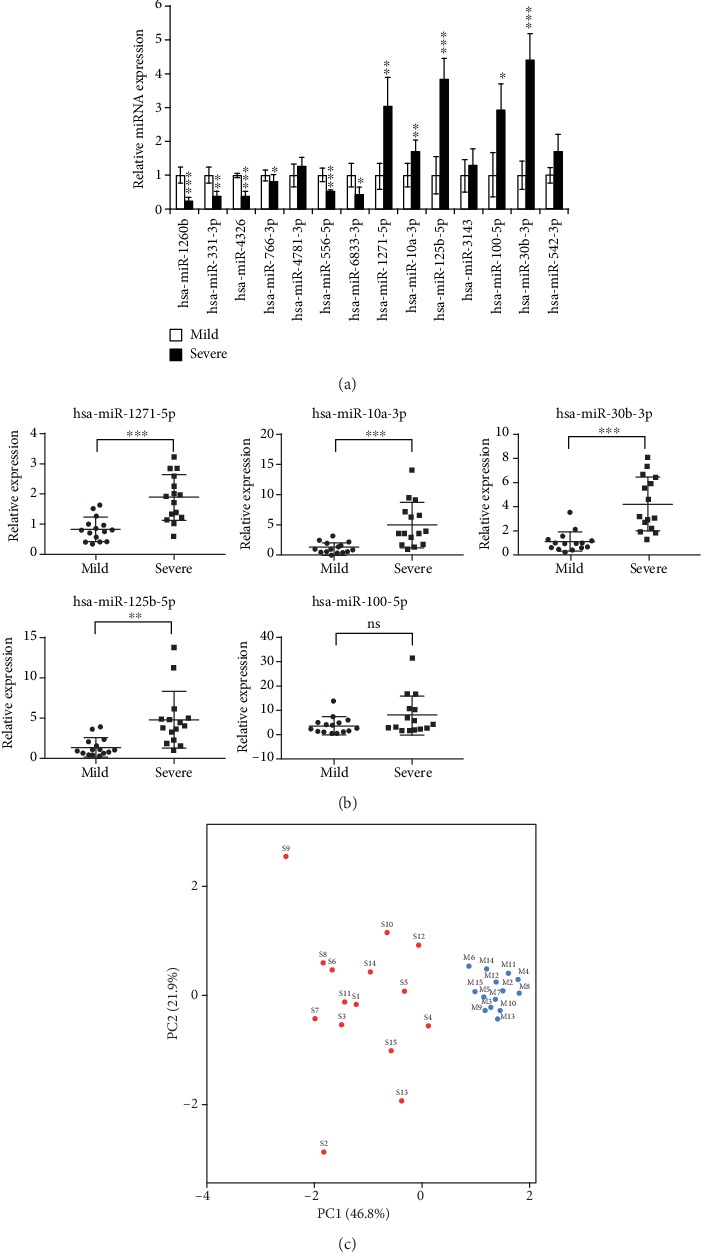
Validation of differentially expressed miRNA expression levels by qRT-PCR. (a) Relative quantities of 14 miRNAs were analyzed for differential expression between groups. Numbers in each group: mild: 5; severe: 5. (b) Quantification of the significantly upregulated miRNAs in (a). Numbers in each group: mild: 15; severe: 15. Data are shown as mean ± SD from three independent experiments. ∗∗P < 0.01 and ∗∗∗P < 0.001 (Student's t-test). ns: not significant. (c) The principle component analysis (PCA) of the significantly upregulated miRNAs in (b). Mild: children with mild RSV-associated pneumonia; Severe: children with severe RSV-associated pneumonia.